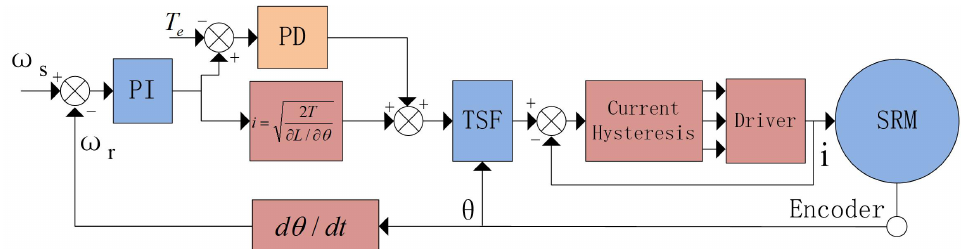
Figure 3. Compensation by PD controller.